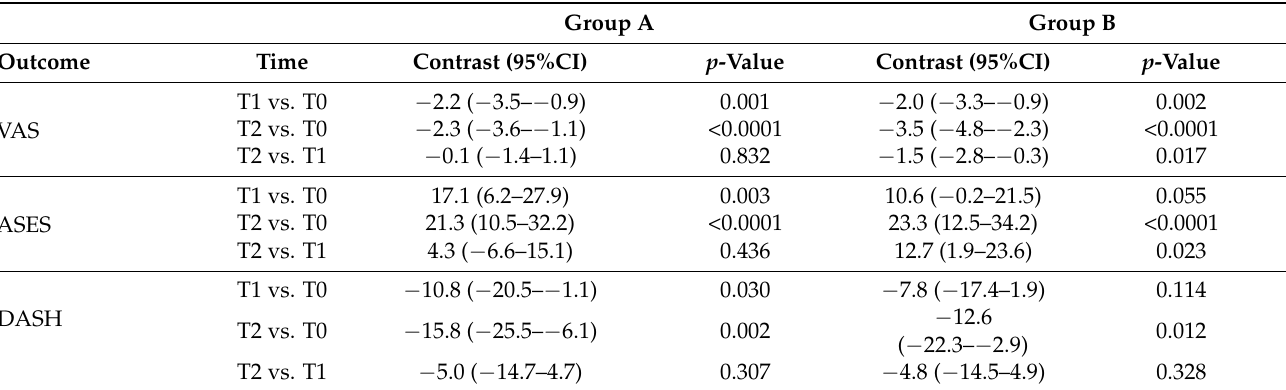
Table 3. Outcome variations between times, by group. Group A Group